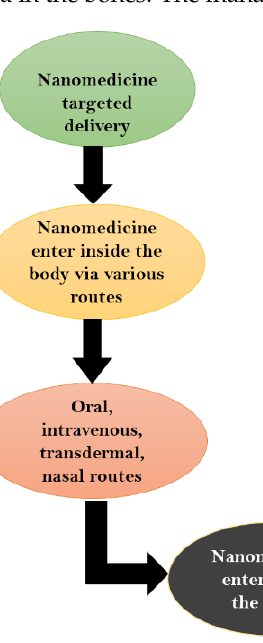
Figure 5. Mechanism of nanomedicine delivery in bone diseases.